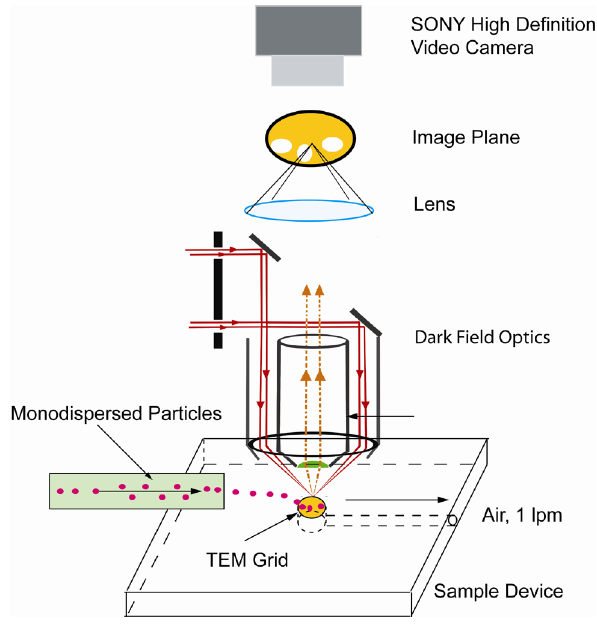
Figure 3 . Fig. 3. A schematic showing the proof-of-concept setup of the Fast-